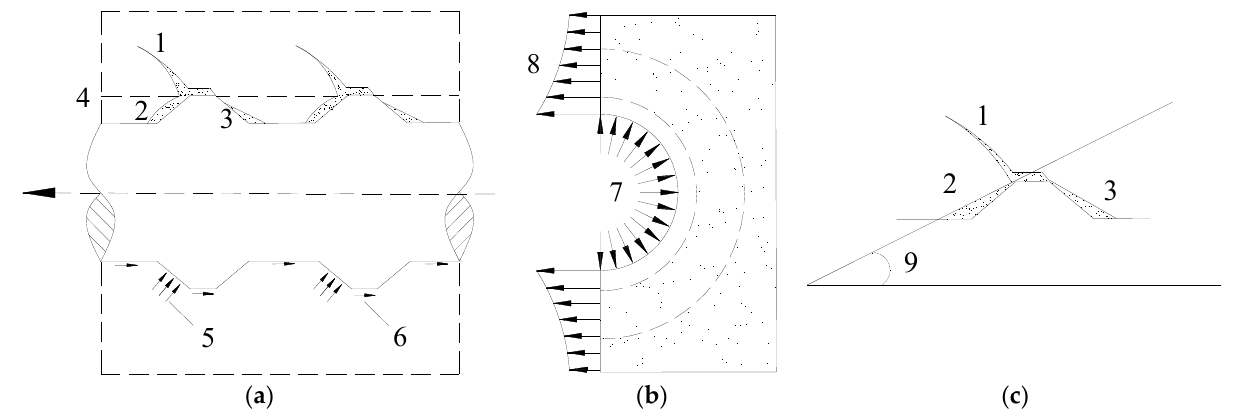
Figure 6. Crack development in the ECC during the pullout process of the steel bar. ( a ) Crack development in the ECC; ( b ) circumferential tensile stress in the ECC; ( c ) new slip plane. 1—internal inclined crack; 2—crushed area in front of the steel bar rib; 3—interval area behind the steel bar rib; 4—shear surface; 5—extrusion force; 6—friction; 7—radial extrusion stress; 8—circumferential tensile stress; 9—inclination angle.